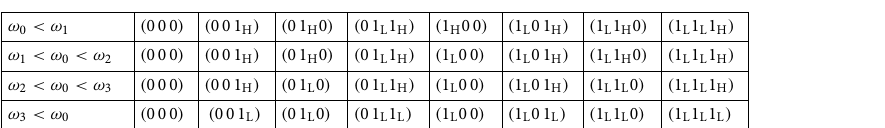
Table 1. Theoretically predicted asymptotic configurations of a three-leaf star network for four different possibilities of the hub frequency to fall into different frequency intervals of the leaves. The first column lists the possible inequalities for the hub frequency, and the next eight columns show the codes of the corresponding allowed configurations.